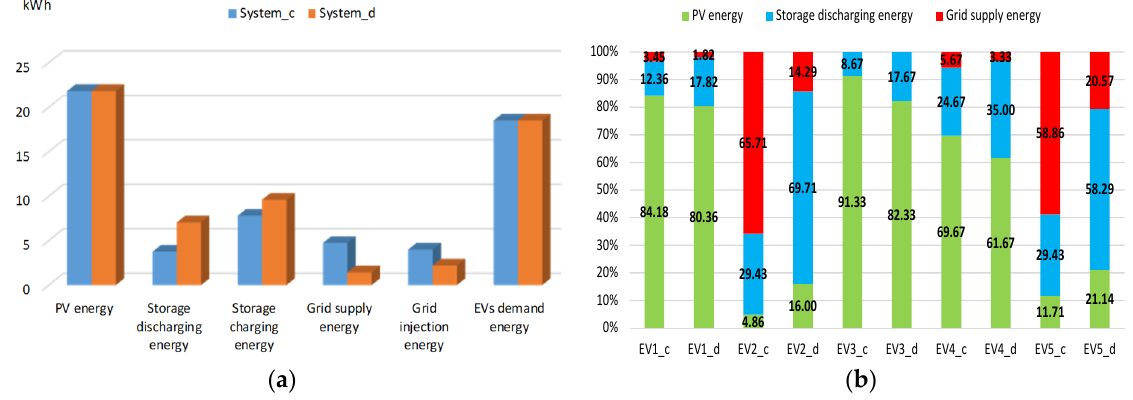
Figure 22. ( a ) Energy system distribution; ( b ) EVs energy distribution for Scenarios 2c and 2d.